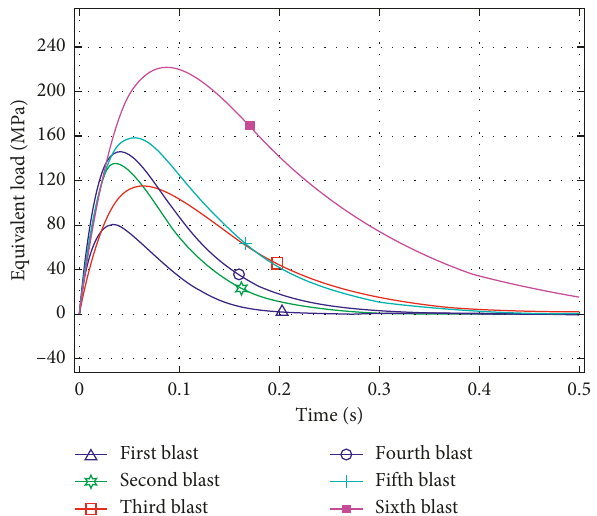
Figure 5: Equivalent load curve of blasting.